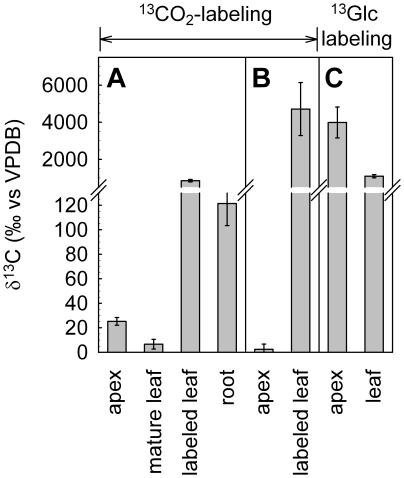
Analysis of δ13C in bulk material of poplar.(A) Intact plants labeled with 13CO2, (B) shoots labeled with 13CO2, and (C) shoots fed with 13Glc. Data represent the mean of 3 experiments ± s.e.